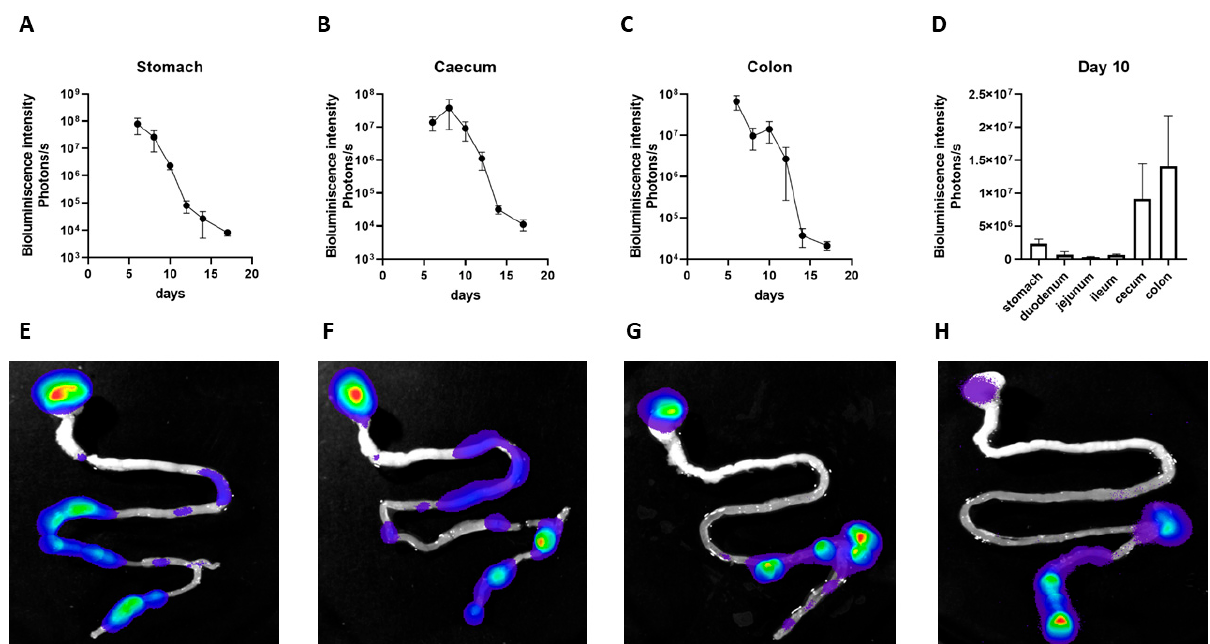
Figure 4. Tracking of colonization capacity of E. coli O83:K24:H31 (EcO83) in particular parts of gastrointestinal tract of neonatal mice. Mice were colonized by transfected strain of EcO83 expressing luciferase and the presence of EcO83 in gastrointestinal tract of neonatal mice was followed by measurement of bioluminescence activity using bioimaging. The dynamics of bioluminescence intensity is shown for stomach ( A ), caecum ( B ), and colon ( C ). The difference in presence of EcO83 among particular parts of gastrointestinal tract measured by bioluminescence intensity at day 10 is shown in ( D ). Each time point represents mean with standard error mean from three mice from one representative experiment. Representative photos documenting the dynamics of colonization capacity of EcO83 are shown in ( E – H